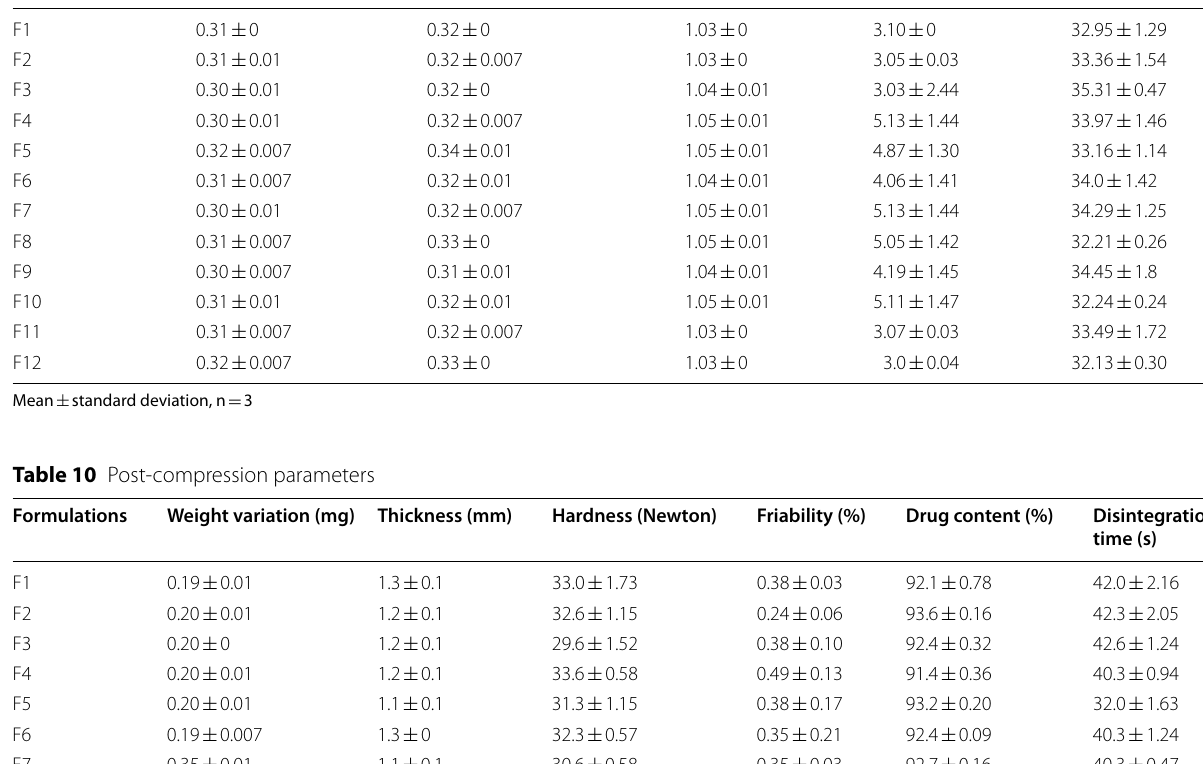
Table 9 Pre-compression parameters